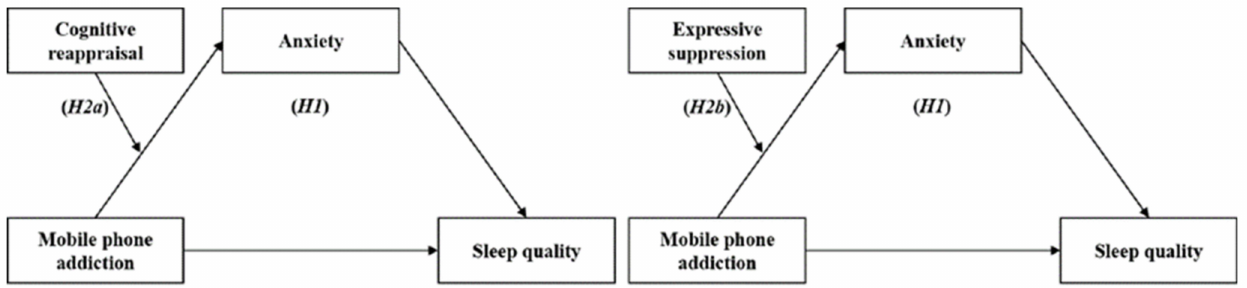
Figure 1. The hypothesized model of each